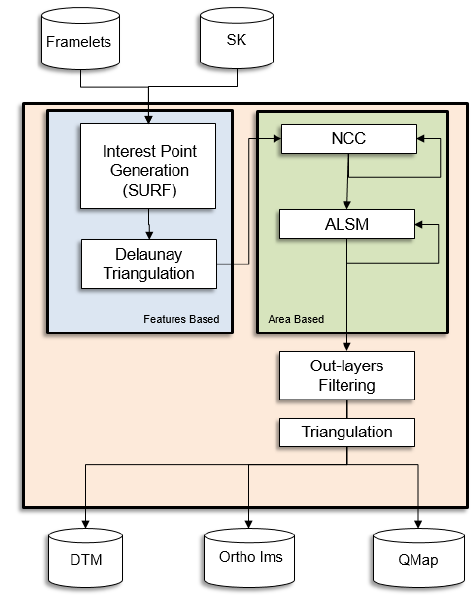
Figure 3 Flow diagram of the processing